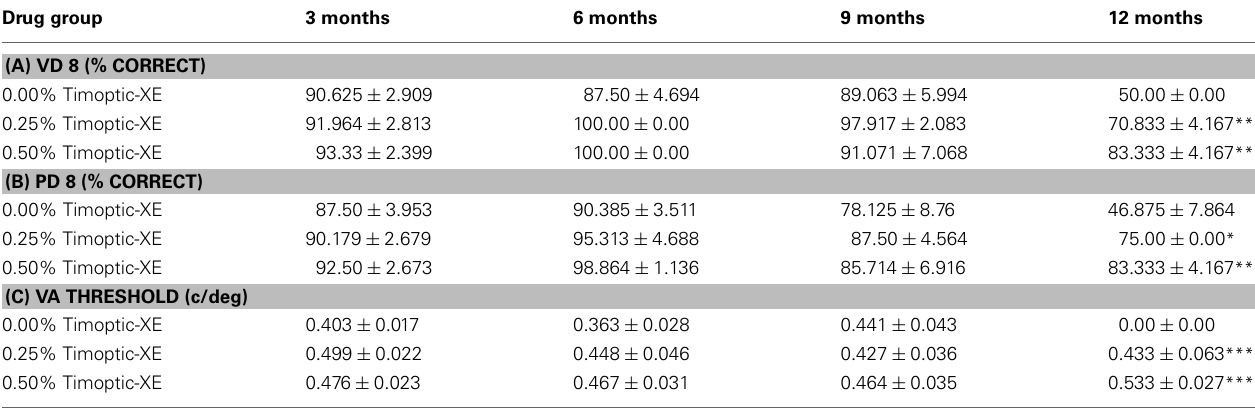
Table 3 | Mean ( ± S.E. ) percent correct on Day 8 of the visual detection (VD 8) and pattern discrimination task (PD 8) and visual acuity thresholds (c/deg) for each drug group in the Visual Water task at 3, 6, 9, and 12 months of